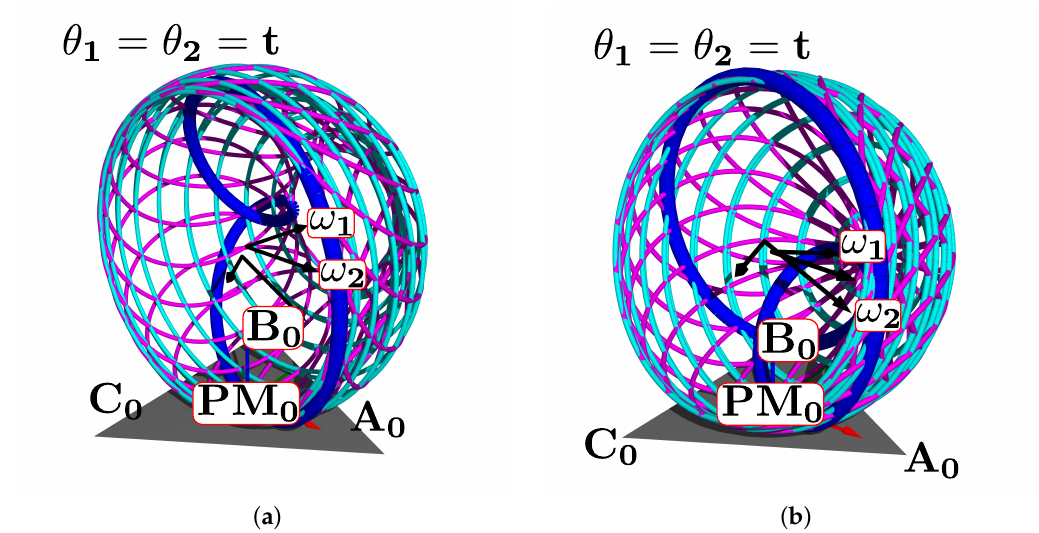
Figure 25. Simulation of the platform central point with variations in the mean statistical values: